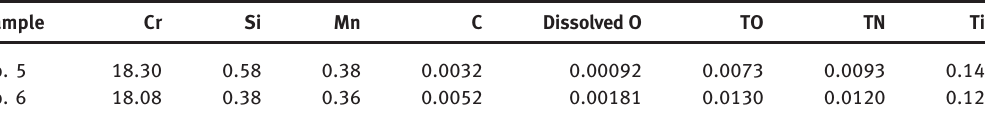
Table 3: Chemical composition of steel (%).